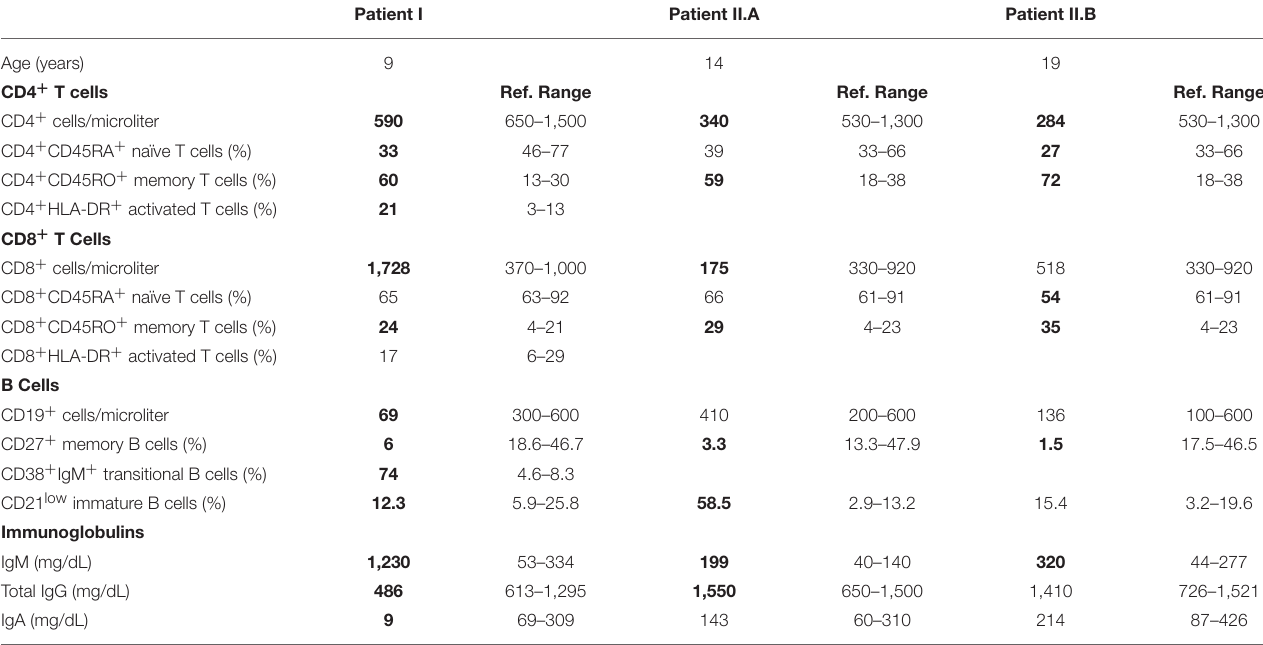
TABLE 1 | Lymphocyte